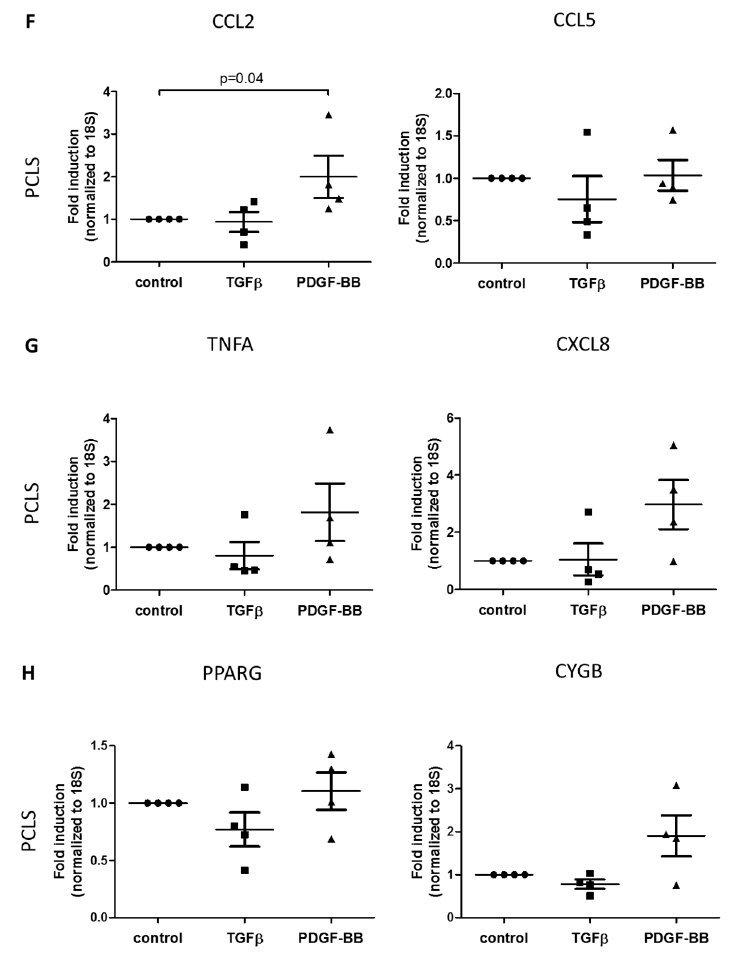
Figure 3. Gene expression levels of several markers for HSC-activities during fibrosis in human precision-cut liver slices ( n = 4) stimulated with TGF β or PDGF-BB. HSC activities and their associated genes include ( A ) activation ( ACTA2, PDGFRB, CCN2 ), ( B ) fibrogenesis ( COL1A1, FN1 ), ( C ) altered matrix degradation ( TIMP1 ), ( D ) proliferation ( CCND1, MKI67 ), ( E ) contractility ( MYLK, ROCK2 ), ( F ) chemotaxis ( CCL2, CCL5 ), ( G ) inflammatory signaling ( TNF, CXCL8 ) and ( H ) reversion ( PPARG, CYGB ). Fold inductions are relative to untreated controls.